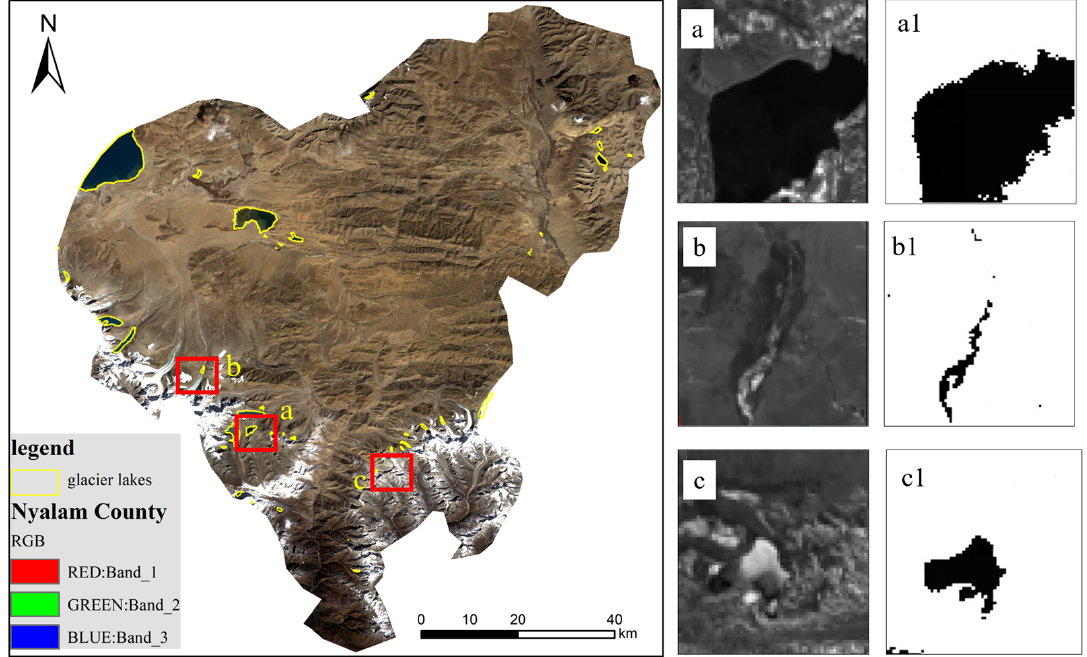
Figure 3. Remote sensing extraction map of the glacial lake area (16 November 2018).